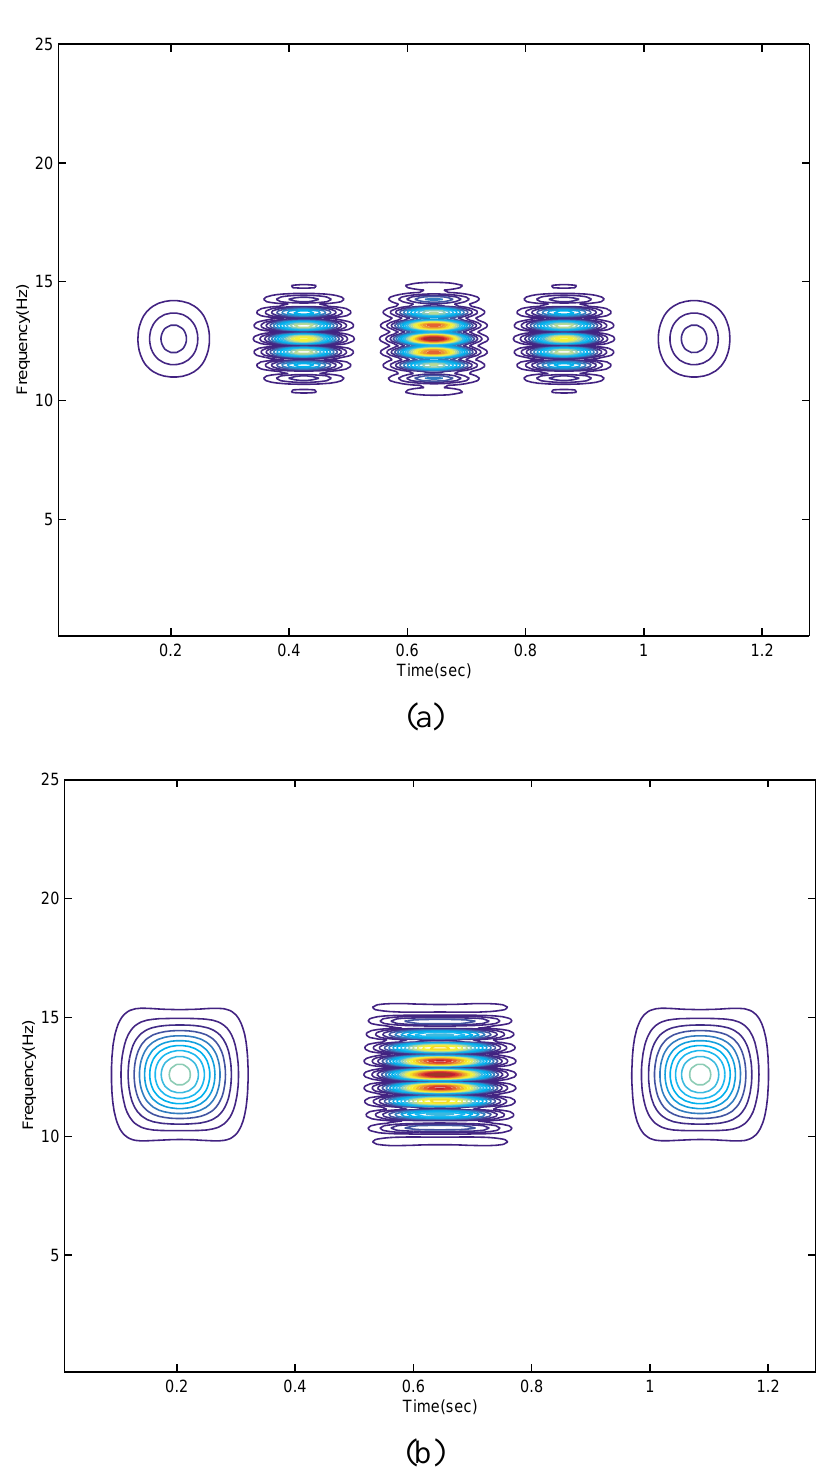
Fig. 2. Comparison between the WVD and SWFOMS for the two component signals centered at 0.2 s and 1.08 s with 12.5 Hz. (a) SWFOMS. (b)